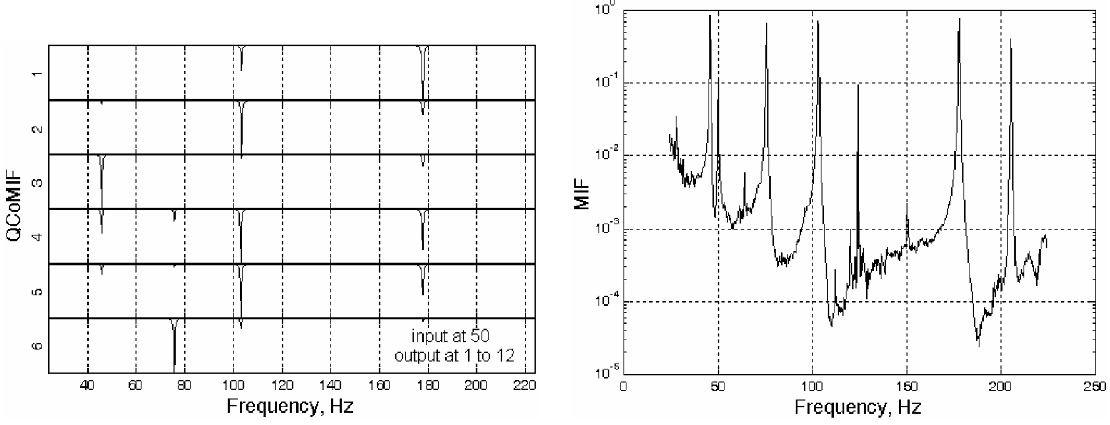
Fig. 24. QCoMIF for the test structure. Fig. 25. MIF for the test